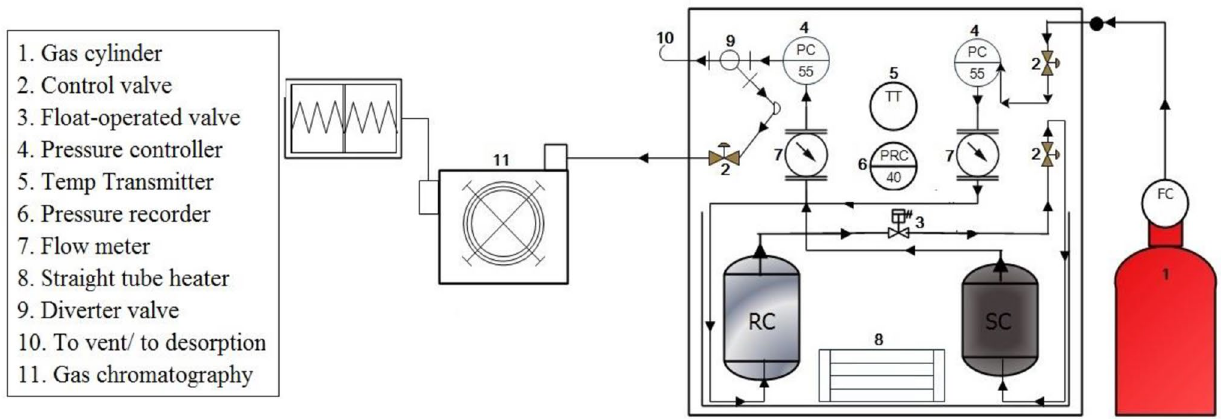
Figure 3. The schematic diagram for the gas adsorption 30